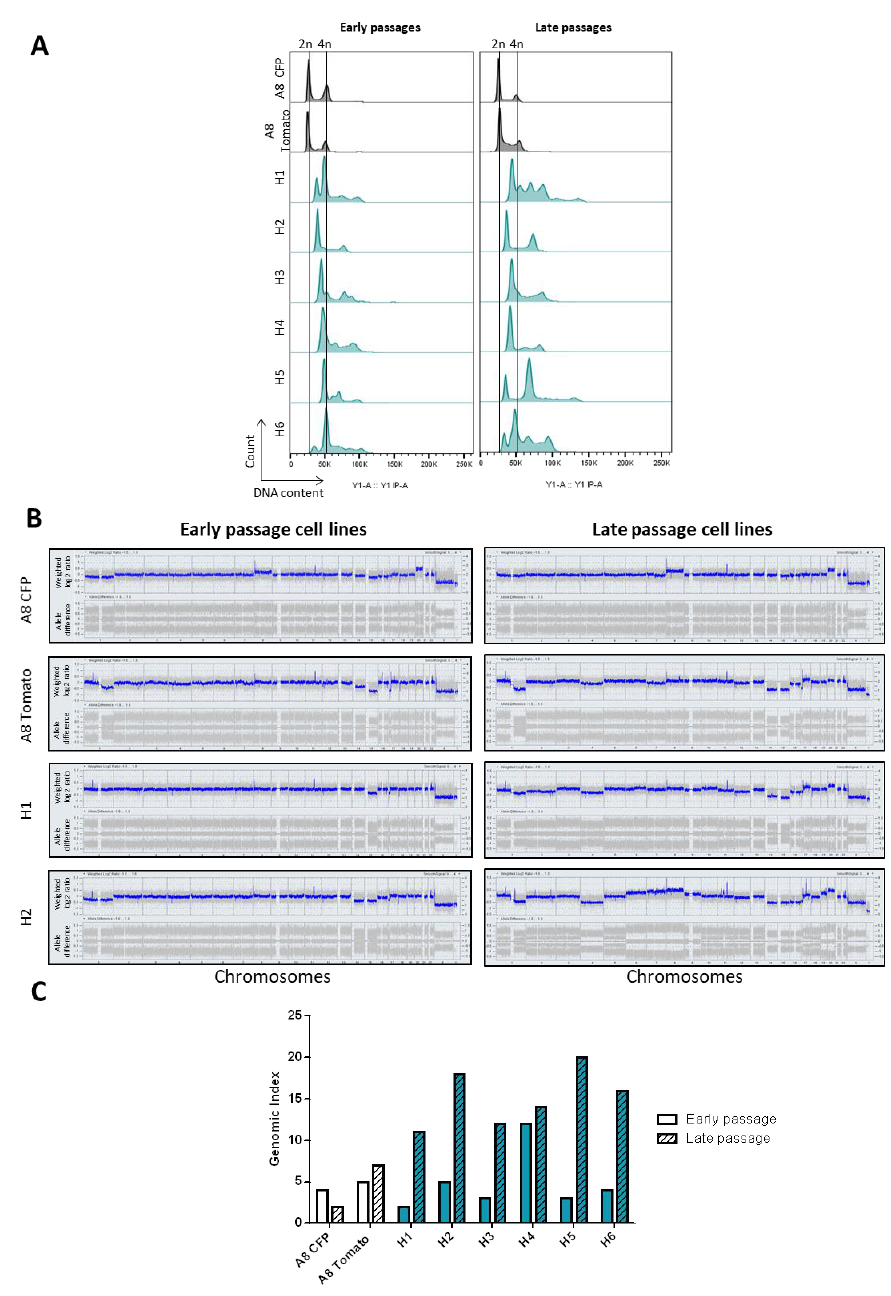
Figure 2. Hybrid cell lines present genomic rearrangements upon fusion and evolve with time. ( A ) FACS analysis of DNA content by measurement of fluorescent PI intensity. x -axis represents fluorescence intensity that is correlated with DNA content, y -axis represents the number of events detected. ( B ) Genomic profiling of parental and two hybrid cell lines at di ff erent passages. x -axis represents chromosome 1 to Y; y -axis represents CNV log2(ratio) (upper lane) and allele di ff erence (lower lane). ( C ) Genomic index values of parental and hybrid cell lines at early and late passages. GI = A 2 / C where A corresponds to total number of alterations and C to number of chromosomes a ff ected by these